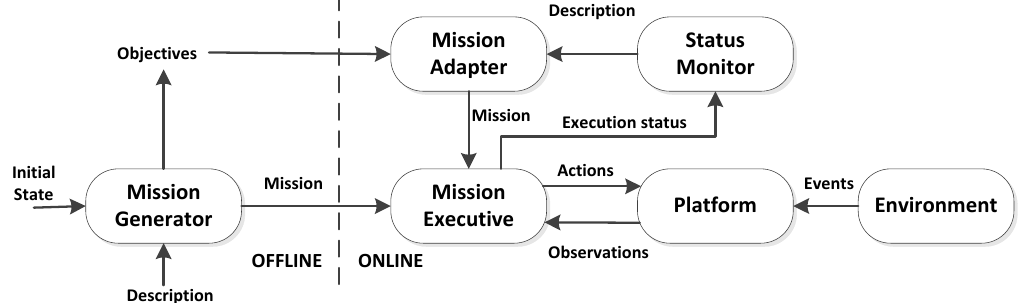
Figure 7. Semantic knowledge-based framework in Trident, as described in [41].